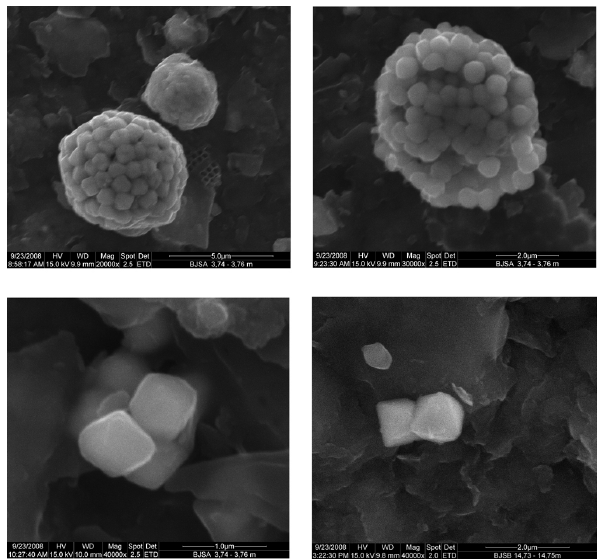
Fig. 4. Pyrite crystals from sites JS-A and JS-B. Framboidal pyrite indicates formation upon microbial sulfate reduction close to the sediment-water interface. Differences in framboid sizes are in agreement with dynamic redox conditions and oxic bottom waters (Wilkin et al., 1996). In contrast, the single euhedral crystals were formed within the sediment later upon activity of sulfate reducers (Wang and Morse,